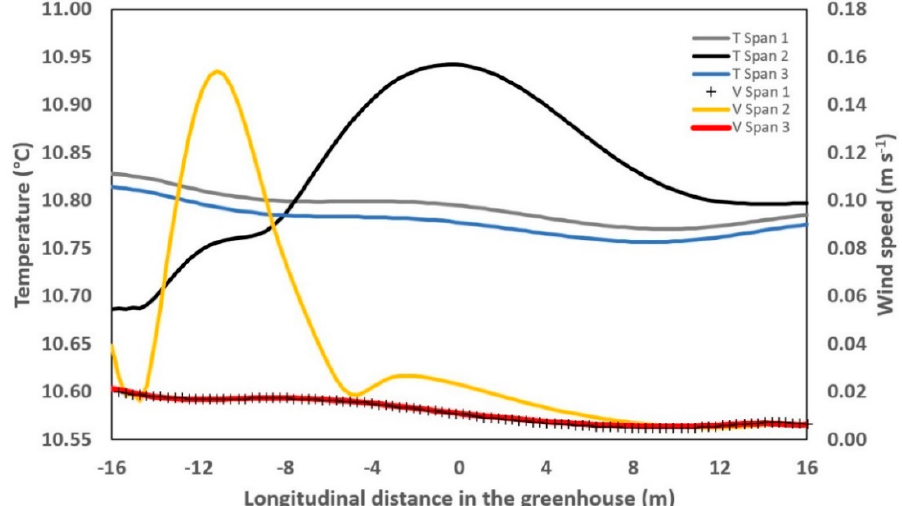
Figure 4. Temperature distribution (°C) and wind speed (m s − 1 ) to 2 m high.